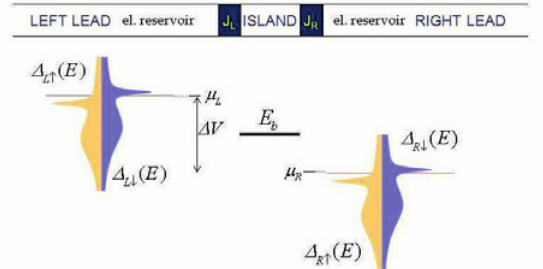
Fig. 1. Sketch of the molecular bridge. The leads are given a sym- metrical bias with respect to the empty level of the island bound state as given by the di ff erence of the quasi-Fermi levels, . The tunneling spectral densities float with the respective Fermi levels. Shown is the case of a parallel magnetization of both